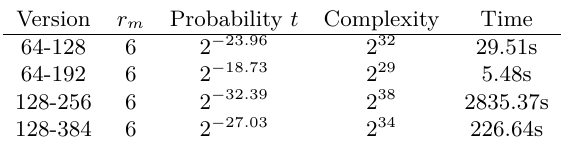
Table 2: Experiments on the middle part of the boomerang distinguishers for SKINNY